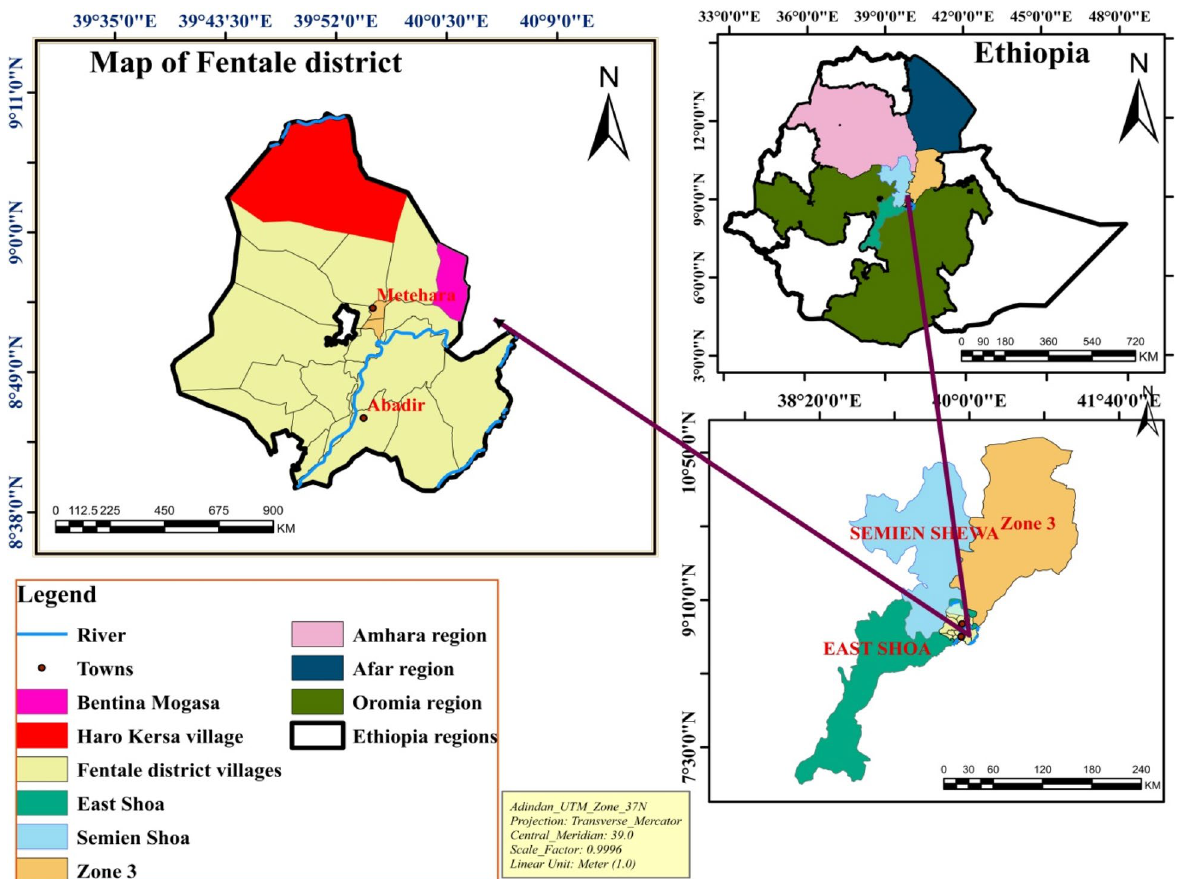
Fig. 1 A map of the study area extracted from the Ethiopian GES (a map made by Gemechu